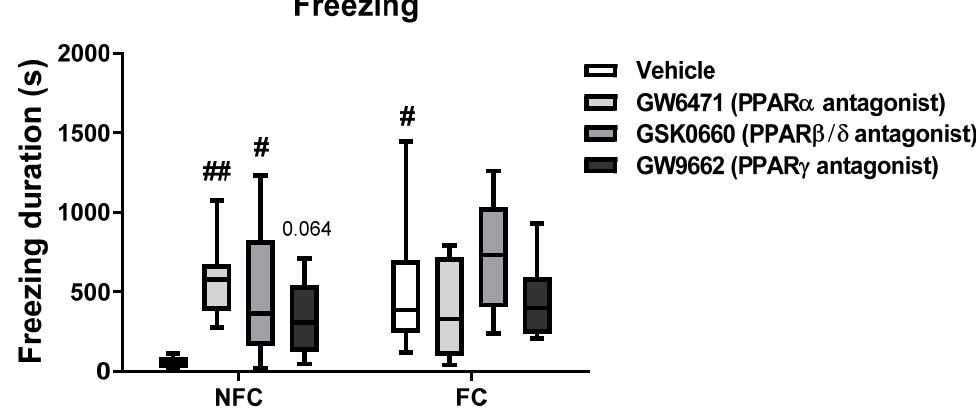
Figure 10. Effects of fear conditioning and intra-BLA administration of selective PPAR α , PPAR β / δ , and PPAR γ antagonists on total freezing duration. Post hoc indicated an increase in freezing duration in FC Vehicle rats ( # p < 0.05, vs. NFC Vehicle). The treatment with GW6471 and GSK0660 in NFC rats also increased freezing duration ( ## p < 0.01 vs. NFC Vehicle; # p < 0.05 vs. NFC Vehicle). Treatment with GW9662 almost reached statistical significance ( p = 0.064, vs. NFC Vehicle). Data are expressed as median with interquartile range and min/max ( n = 7–9 rats per group).